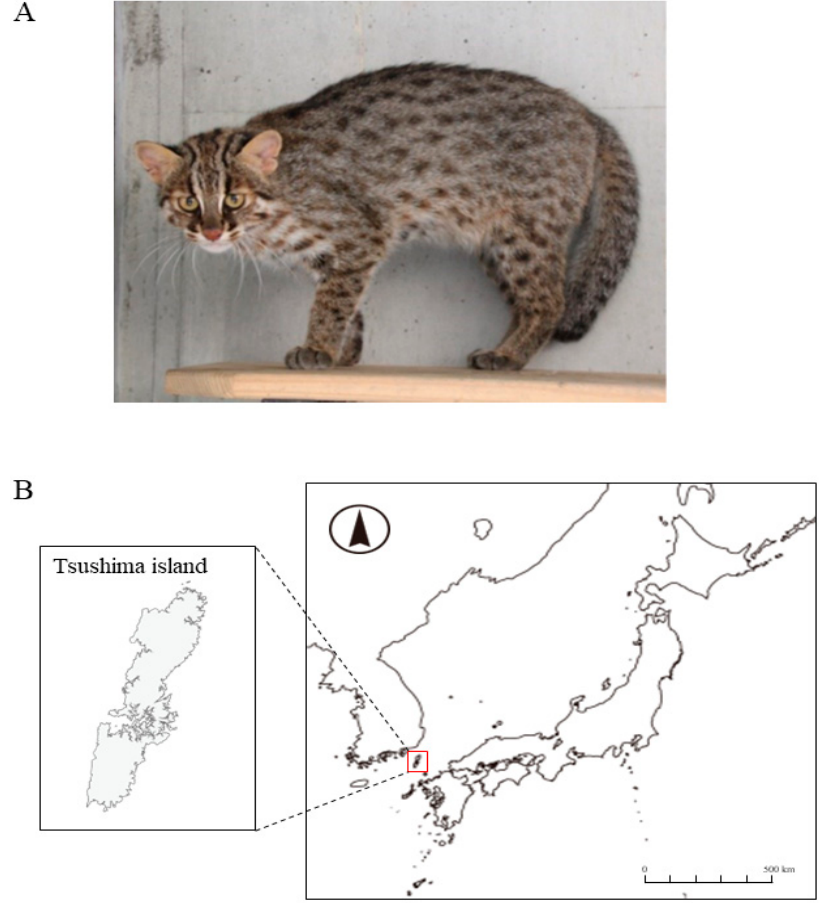
Figure 1. ( A ) Photograph of Tsushima leopard cat, ( B ) Location of Tsushima